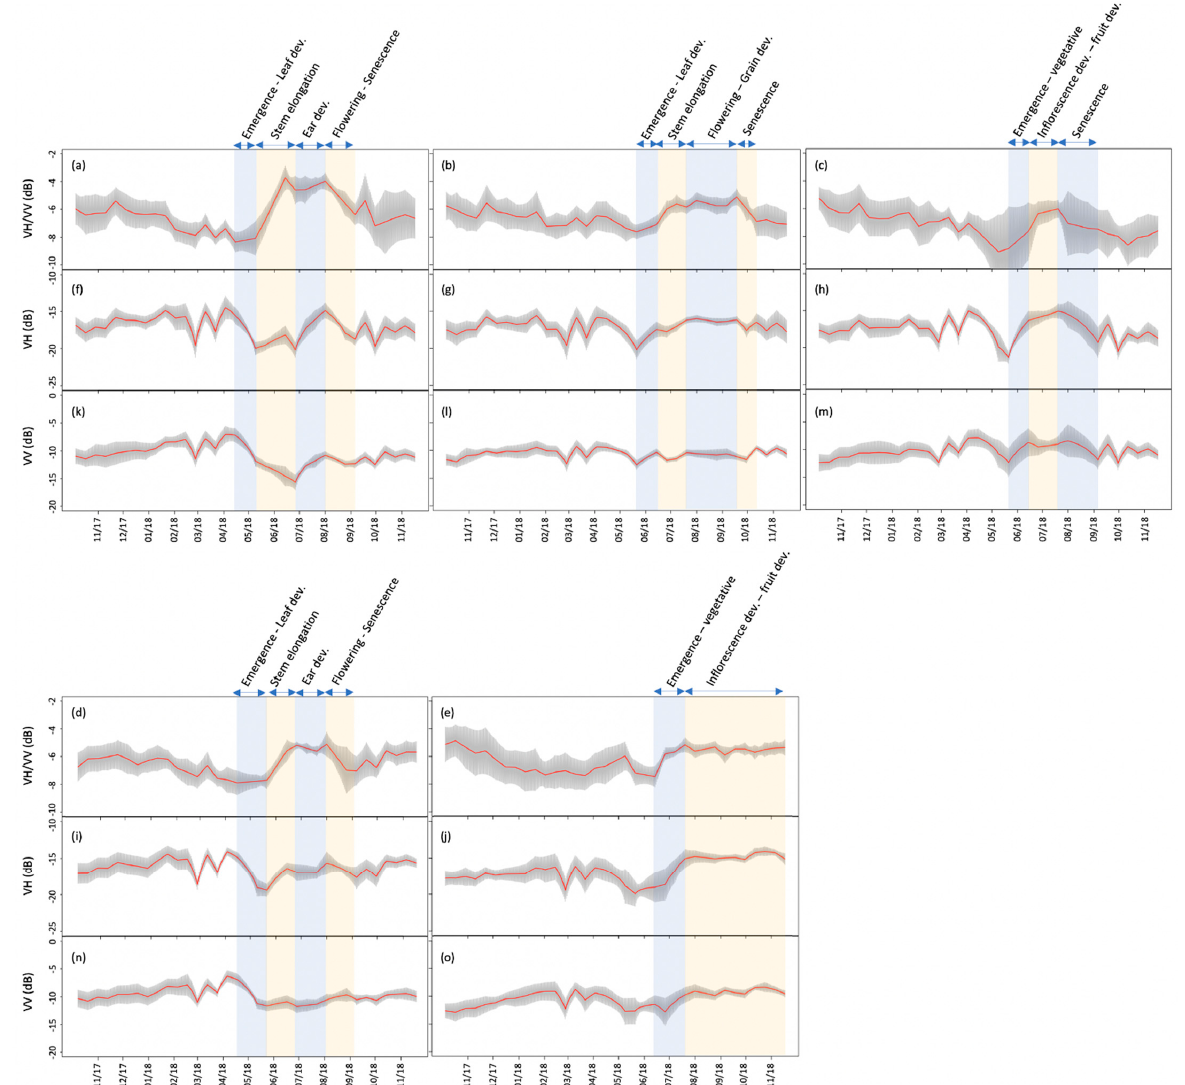
Figure 5. Median VH/VV, VH and VV time series (in red) and standard deviation (in grey) for the ten plots of spring barley ( a,f,k ), maize ( b,g,l ), potatoes ( c,h,m ), spring wheat ( d,i,n ), and beets ( e,j,o ) used for benchmarking. Key dynamics are indicated with reference to the knowledge-based crop growth stages.